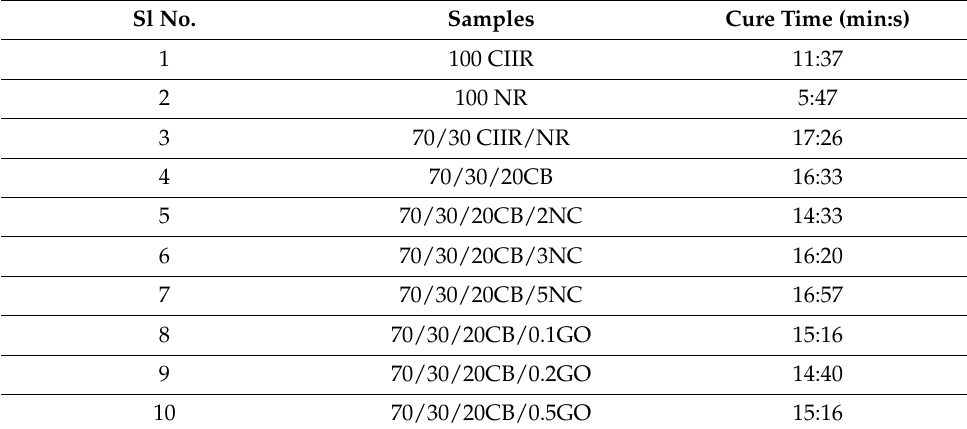
Table 3. Cure characteristics of polymer nanocomposites.